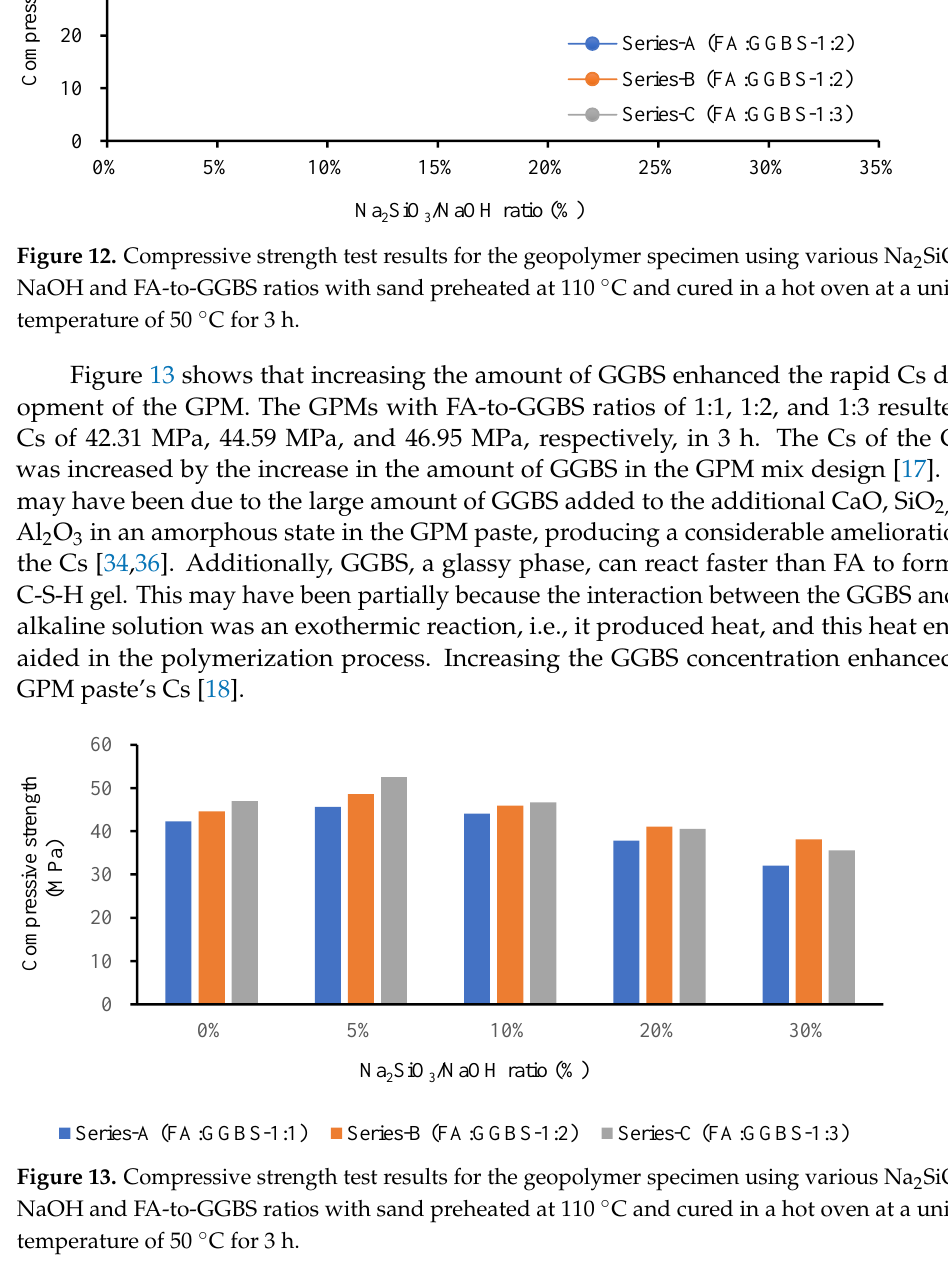
Figure 14. Geopolymer material initial setting time using various Na 2 SiO 3- to-NaOH and FA-to- GGBS ratios with sand preheated at 110 °C. Figure 15 . The final setting time of the geopolymer material using various Na 2 SiO 3 -to-NaOH and FA-to-GGBS ratios with sand preheated at 110 °C.